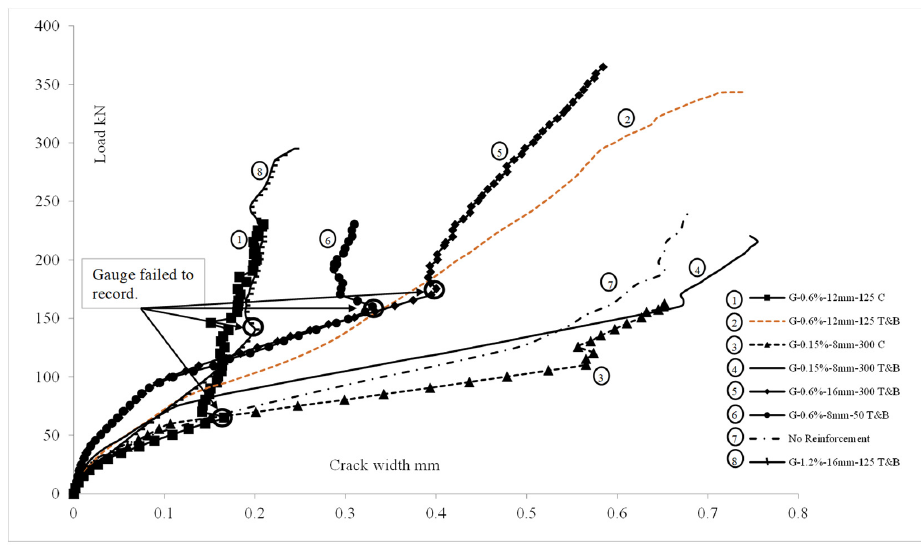
Figure 6. Crack width expansion with load. Crack width exceeded 0.5 mm for the 0.15% GFRP-reinforced slab with the conven- tional two layers at 150 kN. The results show that two layers of 0.6% GFRP reinforcement